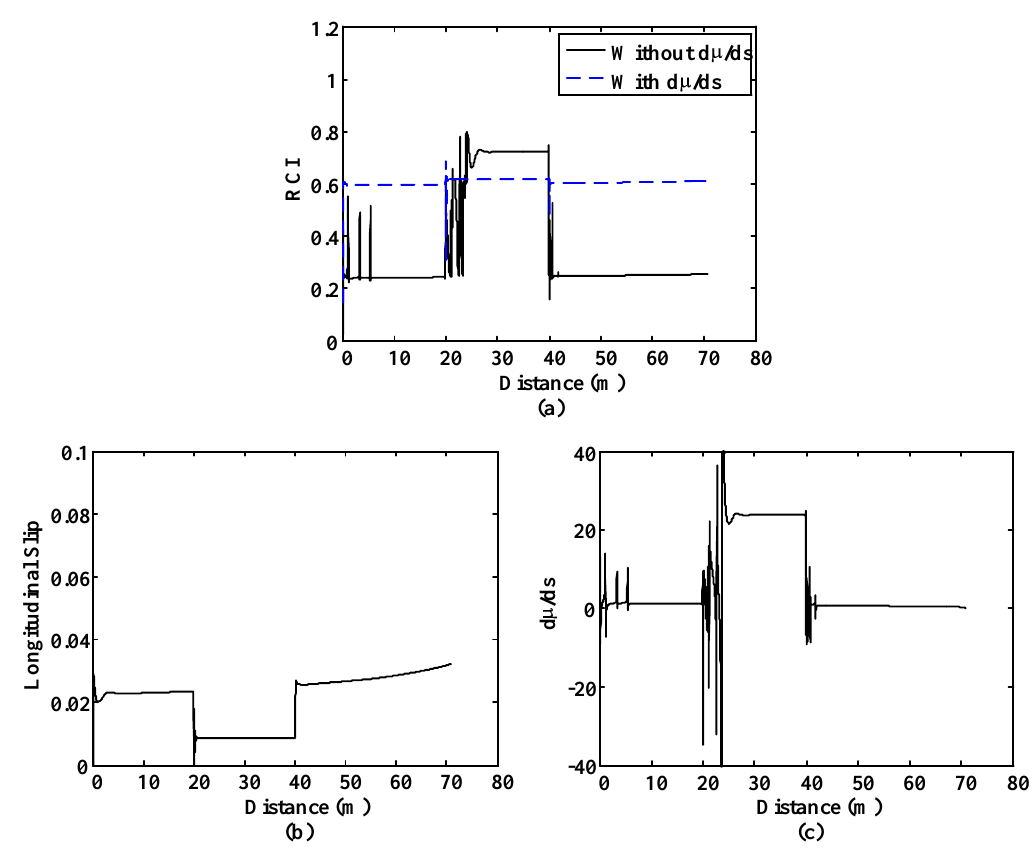
Figure 16. Straight line simulation. Surface transition: 20 m. on µ = 0.2, 20 m. on µ = 0.8 and 60 m. on µ = 0.2. ( a ) Road condition fuzzy block outputs comparative; ( b ) Slip; ( c ) dμ/ds.